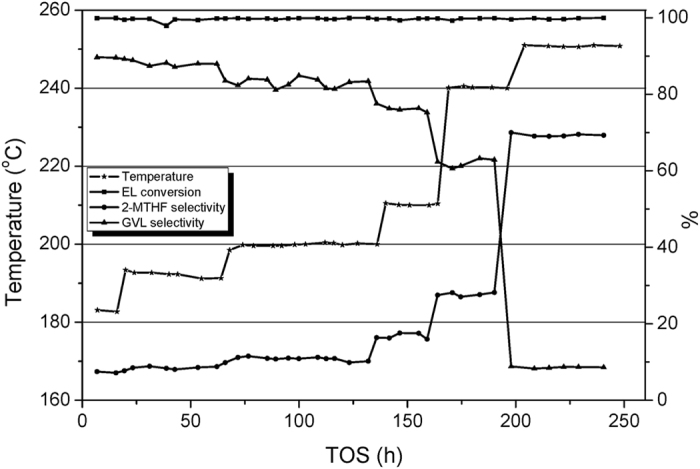
The effect of temperature on the Cu/Al2O3-SiO2 catalyst performance between 170 °C and 250 °C.